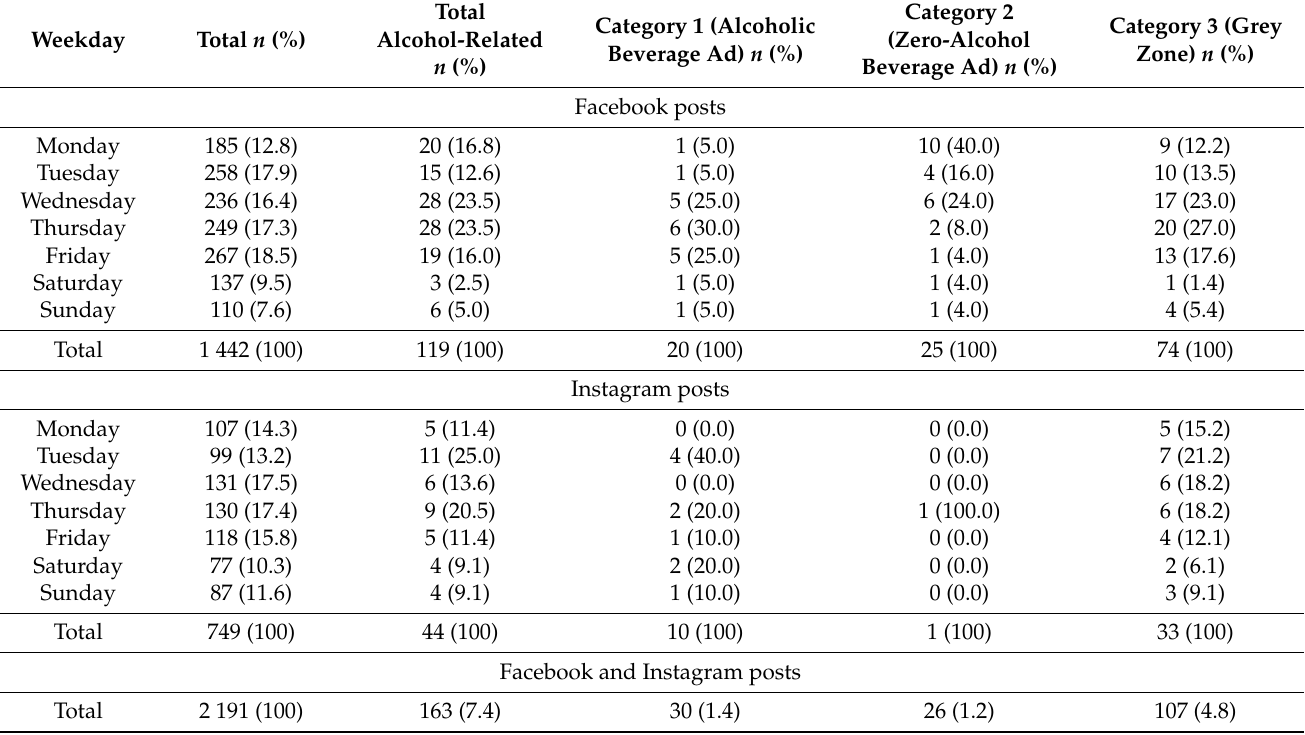
Table 3. Summary of key results by weekday ( n =